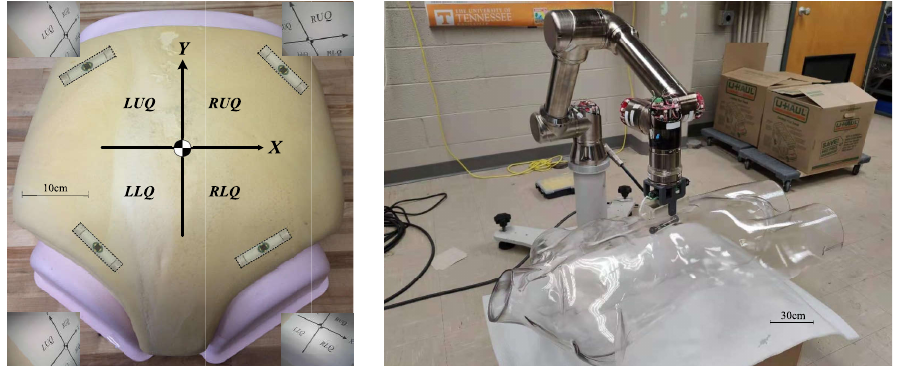
Figure 15. Translation of the camera and another setup for mobility test. A multi-quadrant coordinate frame was placed in the belly for imaging reference. Left upper quadrant (LUQ), left lower quadrant (LLQ), right upper quadrant (RUQ), right lower quadrant